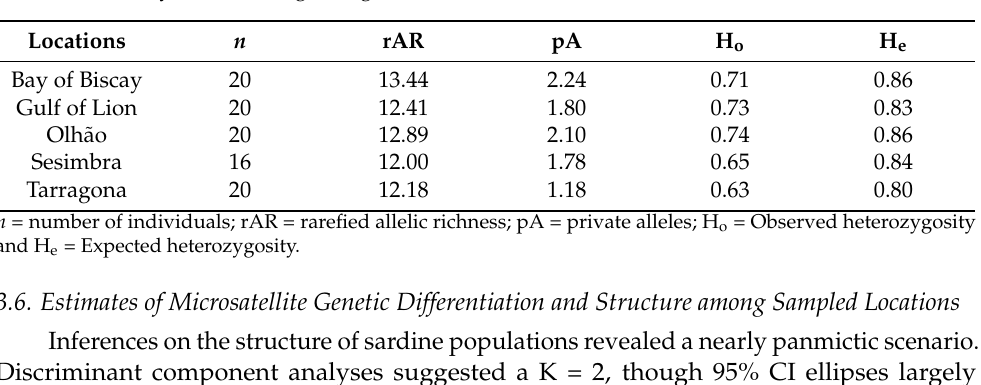
Table 5. Diversity estimates regarding the five microsatellite